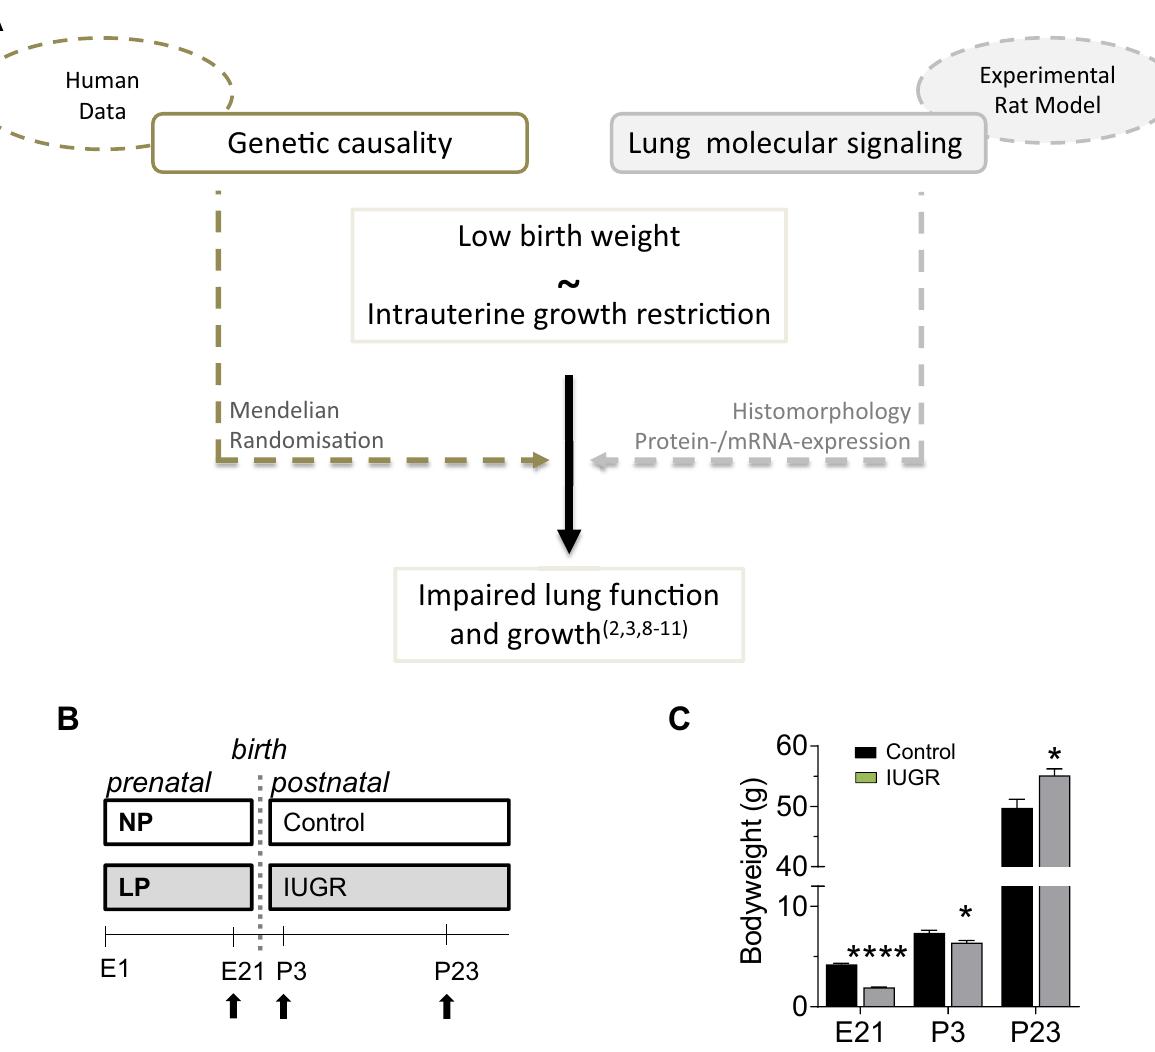
Figure 1. Schematic representation of the study layout, using Mendelian randomisation (left) as a strategy to study the genetic origin of low birth weight, vs. using molecular methods to study the effect of intrauterine growth restriction (IUGR) on lung development (right) ( A ). Timeline of the experimental model in which IUGR is induced with a low protein diet (LP) during gestation in Wistar rats; control dams received normal protein diet (NP). Lungs were harvested at embryonic day 21 (E21), postnatal day 3 (P3) and P23 ( B ). Measurements provide a quantification of the mean body weight of the control and IUGR group on time points E21, P3, and P23 ( C ). Mean ± SEM (n = 10/group). A non-parametric T-test was used to compare IUGR to the control group, *p < 0.05, ****p <